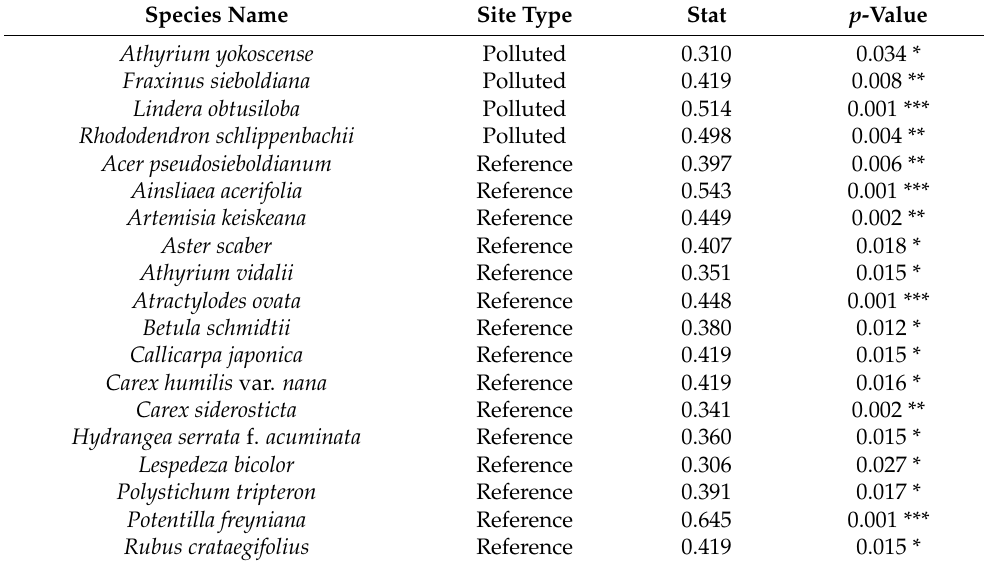
Table 3. The result of indicator species analysis for selecting the disappeared species and tolerant species to the polluted environment based on data collected in both polluted and natural Quercus mongolica forests. Polluted: tolerant species in the polluted site of Quercus mongolica forest; Reference: disappeared species in the natural reference site of Quercus mongolica forest.